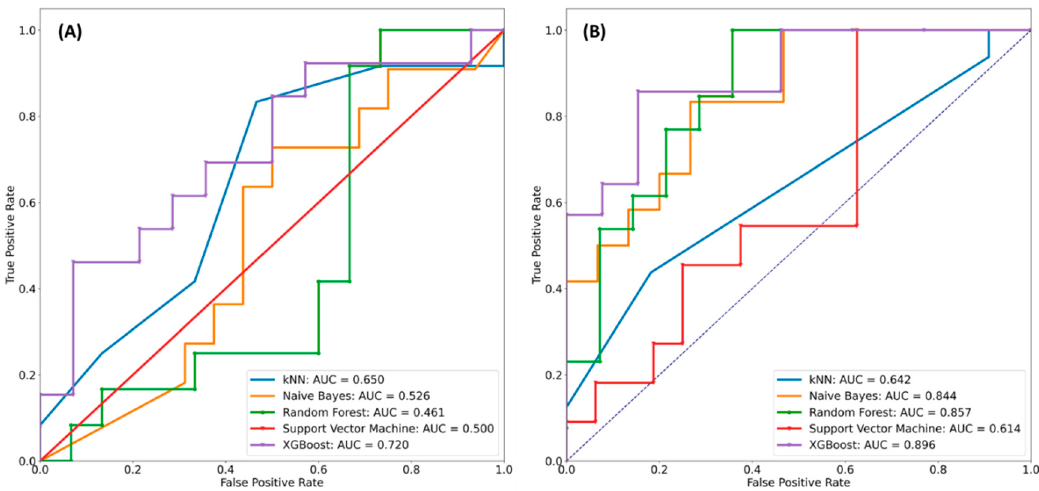
Figure 2. Performance results of different machine learning classifiers in predicting MGMT methylation status. ( A ) All 704 radiomics features. ( B ) Nine top-rank radiomics features.